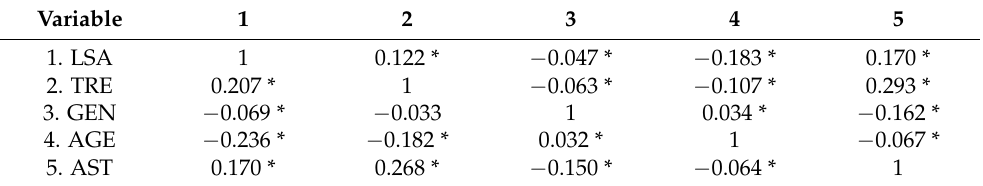
Table 3. Correlation matrix.